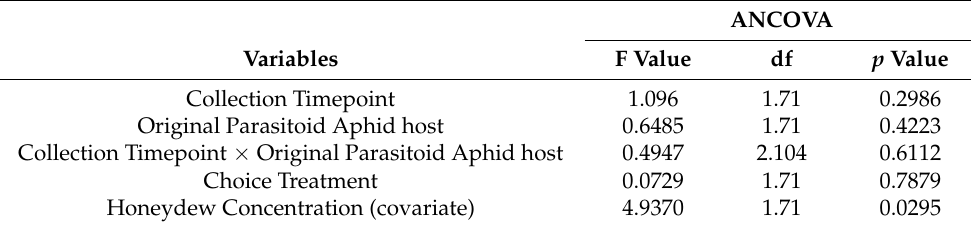
Table 3. Neither Timepoint nor Original Parasitoid Aphid Host Mediated Parasitoid Preference (Measured as the Relative Proportion of Time Spent on Each Treatment) for Grain Sorghum or Johnson Grass Honeydew versus Water. Bolded Values Indicate Statistical Significance at p < 0.05.